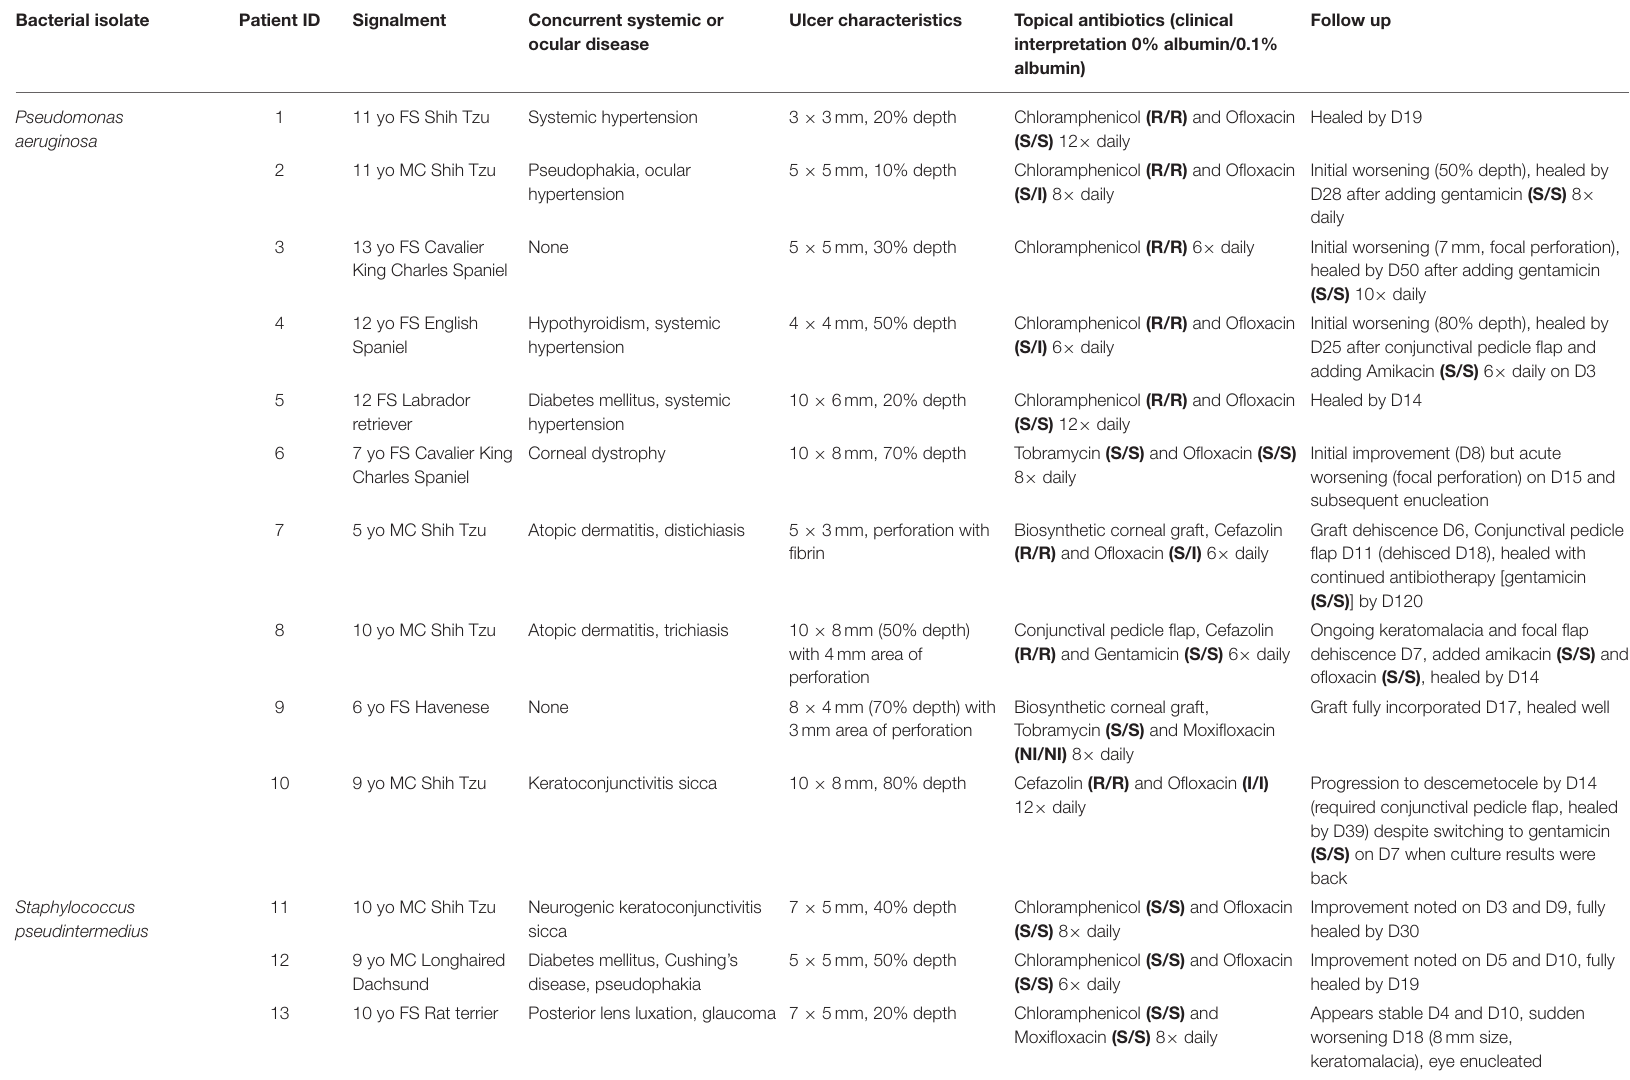
TABLE 3 | Clinical description of 30 canine patients diagnosed with culture-confirmed bacterial keratitis and managed with medical ± surgical therapies. Bacterial